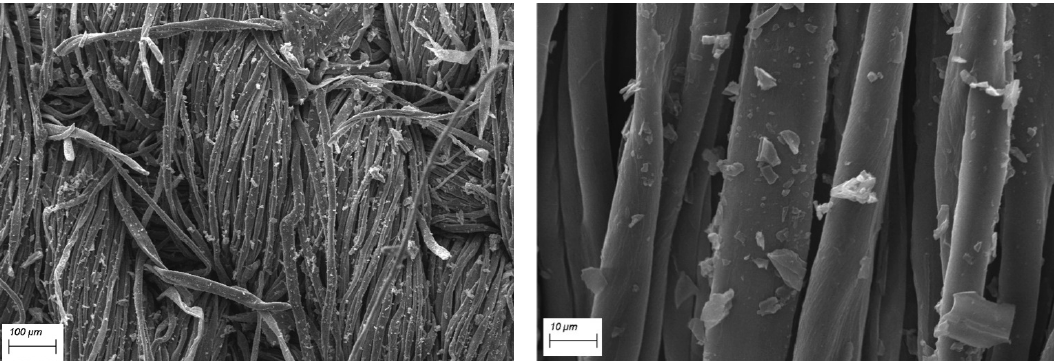
Figure 3. SEM images of COT+PA+BC(8) at different magnifications.